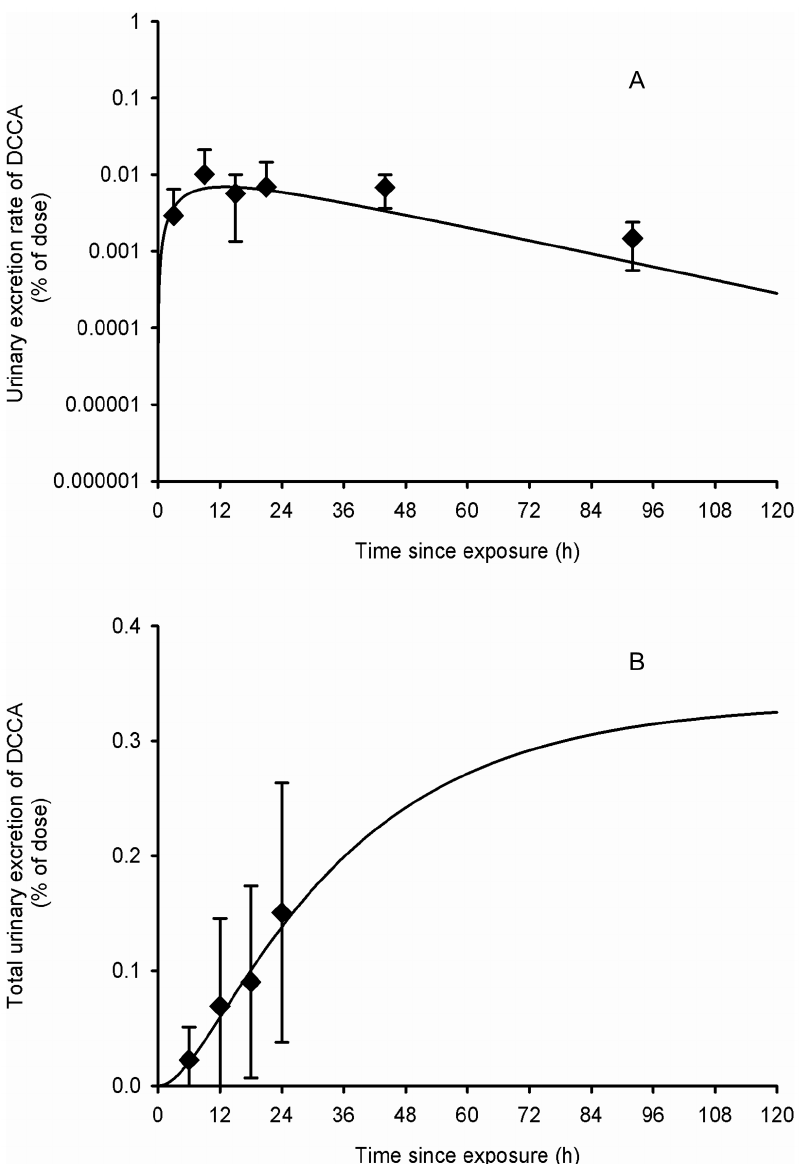
Figure 8. Comparison of model simulations with experimental data for DCCA (scabies patients dermally exposed). Comparison of model simulations (lines) with experimental data of Tomalik-Scharte et al. (2005) (symbols) on the average time courses of DCCA excretion rate (A) and cumulative excretion (B) (% of applied dose) in scabies patients following a whole-body dermal application of a cream containing 3 g of permethrin. Diamond symbols represent average experimental values and vertical bars the experimental standard deviation